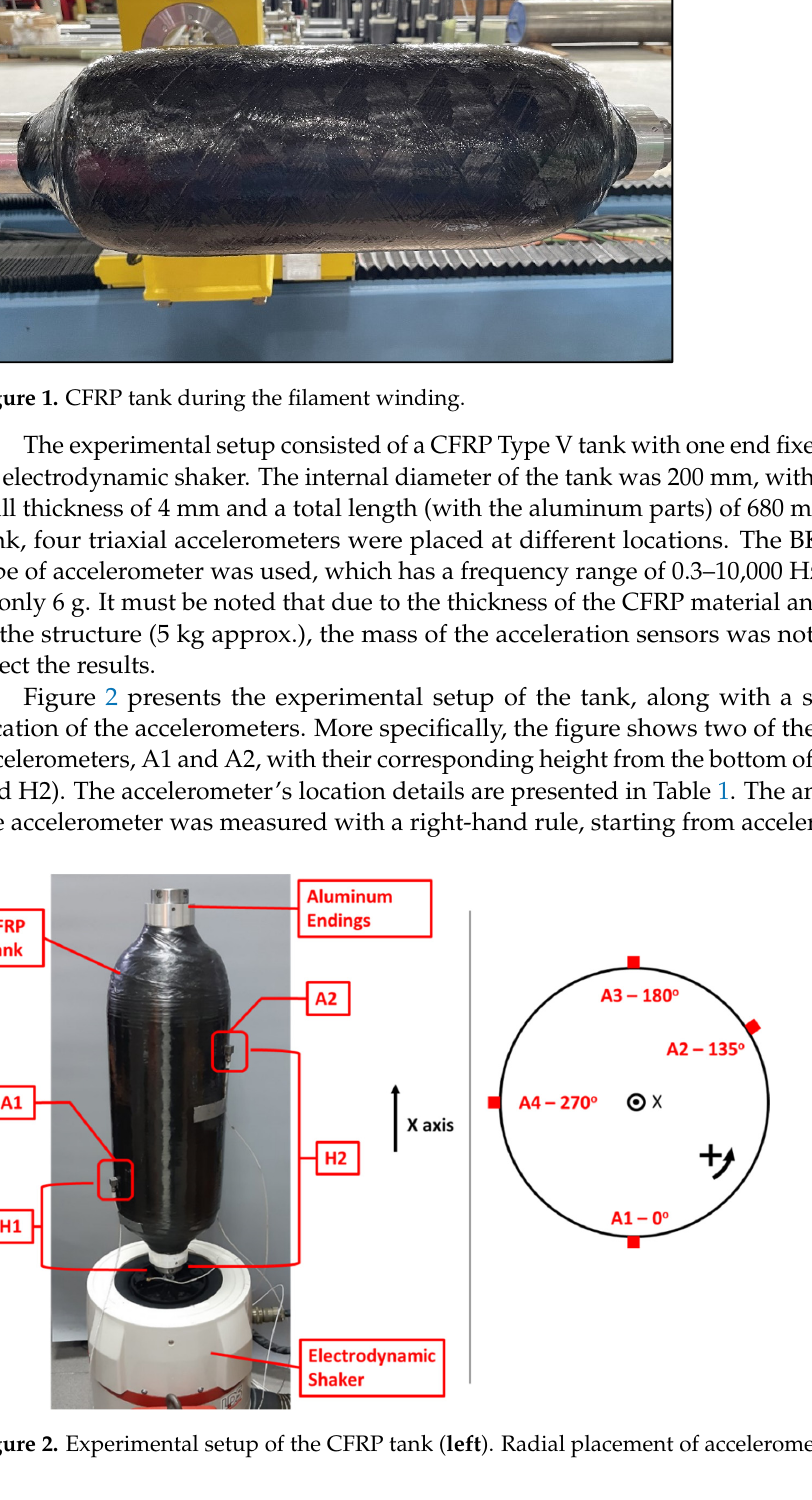
Figure 2. Experimental setup of the CFRP tank ( left ). Radial placement of accelerometers ( right ). The location and number of acceleration sensors were evaluated by the eigenmodes of the structure. A finite element model of the structure was developed using the com- mercial software package MSC Nastran. The indicative eigenmodes from the modal anal- ysis of the model between the range of 0 and 1500 Hz are presented in Figure 3. Figure 3. Indicative eigenmodes of the FE model in the range of 0 to 1500 Hz.